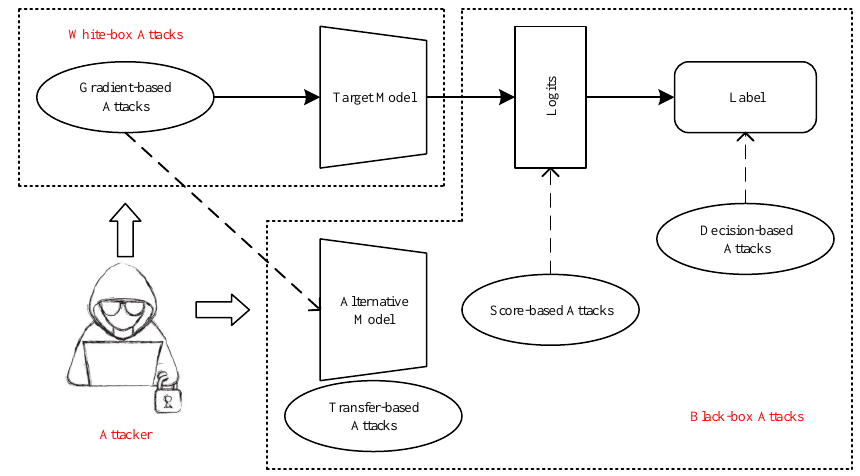
Figure 2. Principles and differences of various types of adversarial